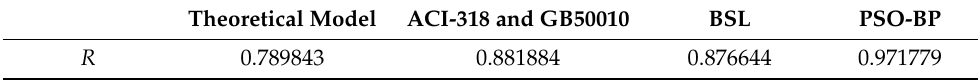
Figure 8. Comparison of PSO-BP with Theoretical Model and Code Model for Yield Strength. Table 5. Correlation Coefficient of Yield Strength.